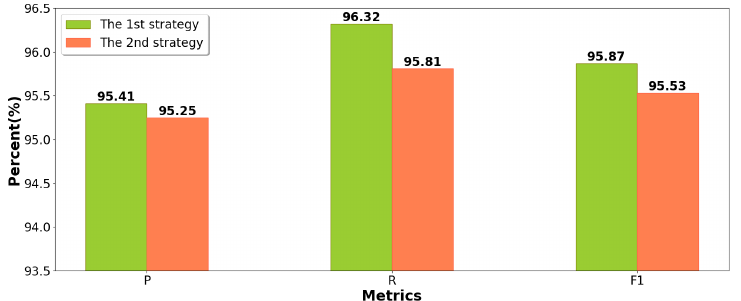
Figure 4. F1 scores of Different Fusion Strategies on Resume (%).